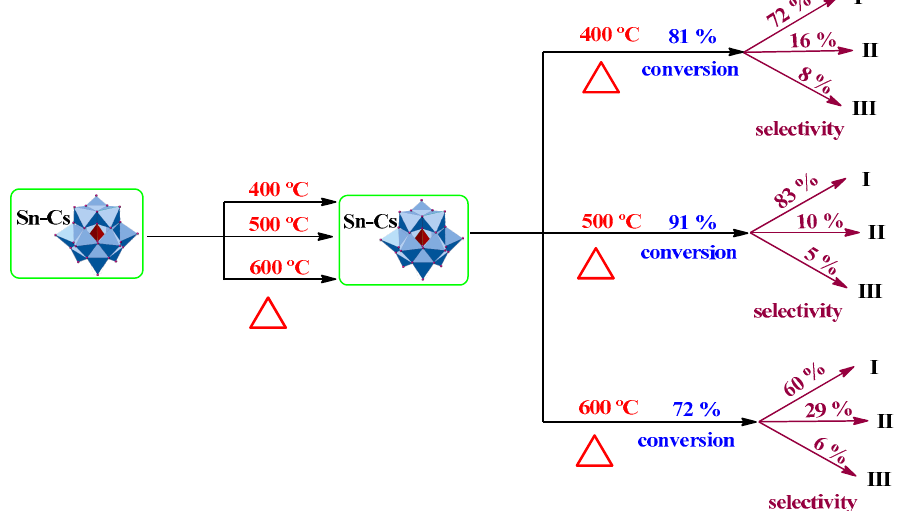
Figure 34. Impact of temperature on the conversion and selectivity of Sn/Cs 3 PW 12 O 40 − catalyzed glycerol carbonation with urea (adapted from ref. [75]).